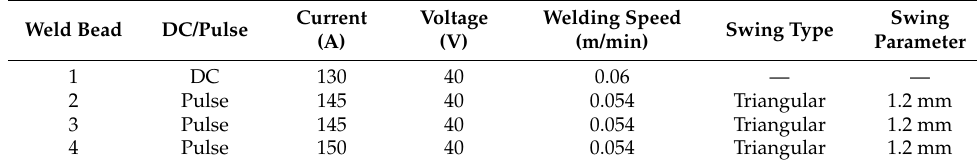
Table 2. Welding process parameters.